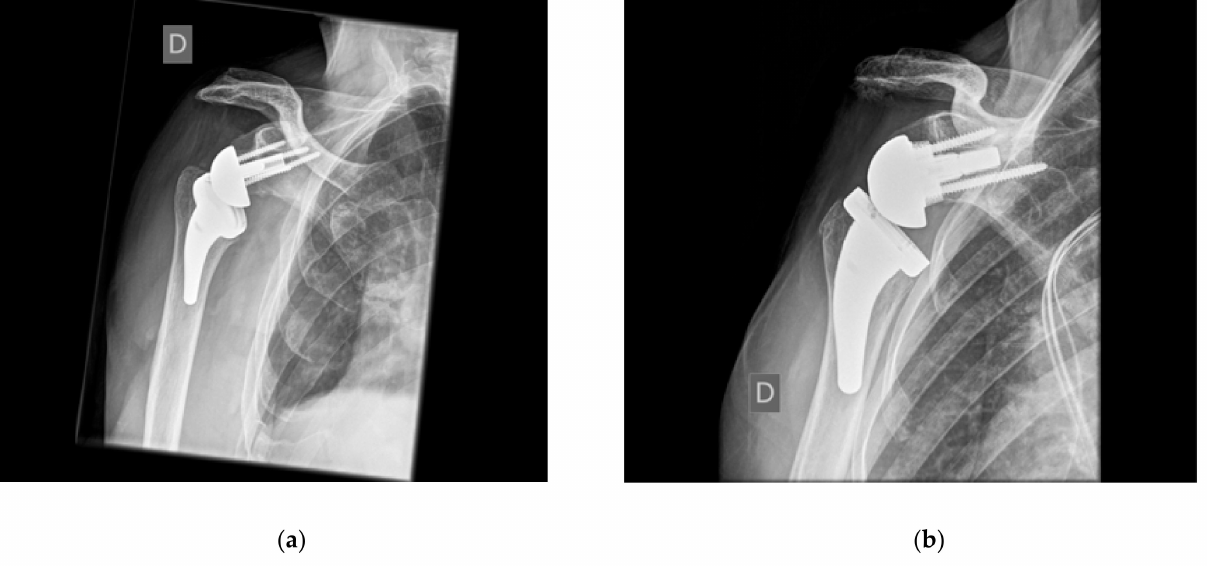
Figure 5. AP radiographs with increased glenoid-sided offset: ( a ) Bony, ( b ) Metal. Minor valgus implantation of